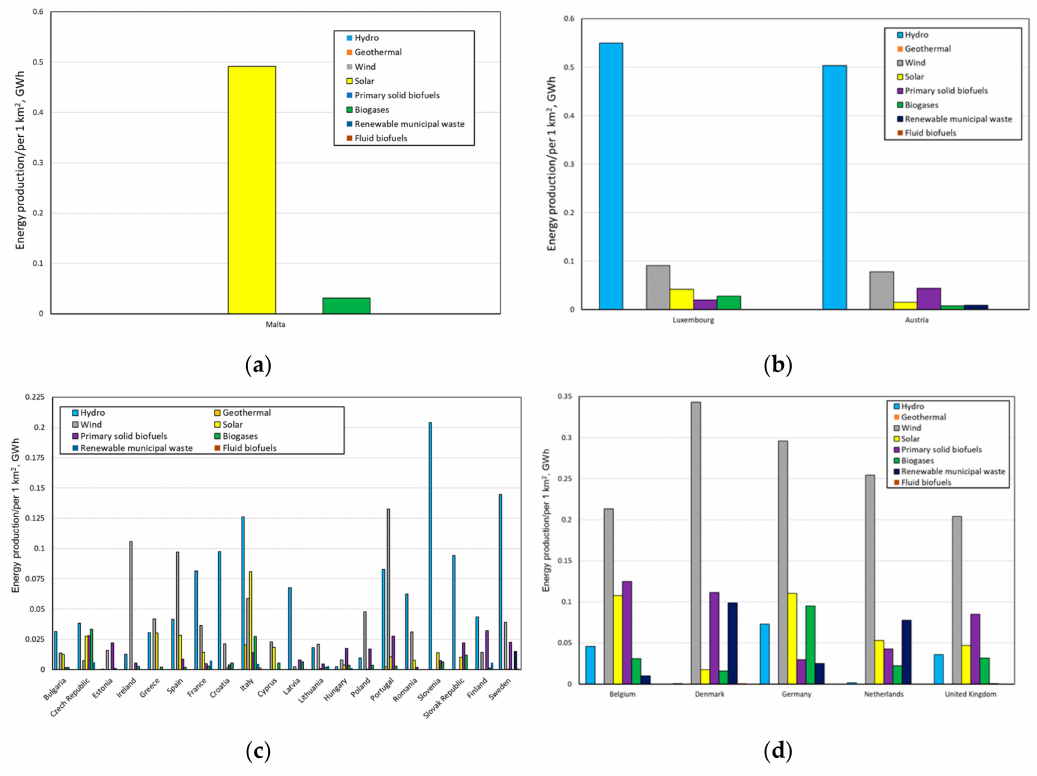
Figure 16. Structure and volume of energy production from renewable energy sources in relation to the area of the countries in individual clusters; cluster 1 ( a ); cluster 2 ( b ); cluster 3 ( c ); cluster 4 ( d ) (own study).